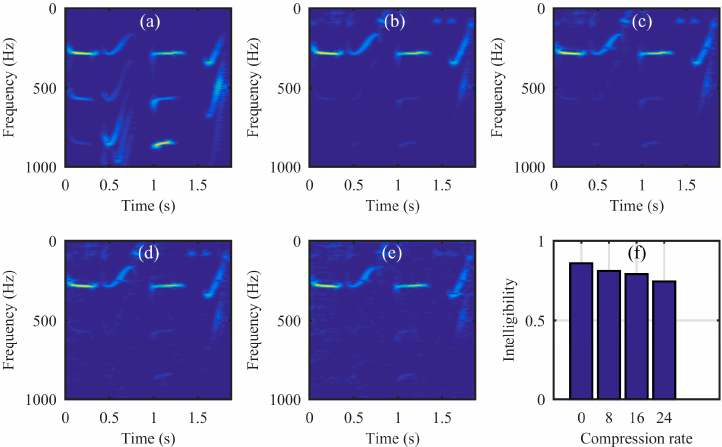
Figure 6. The simulation results for complex sound (speech containing counting from one to four in Chinese). ( a ) The original audio (see supplementary, Media1) spectrogram; ( b ) the audio (see